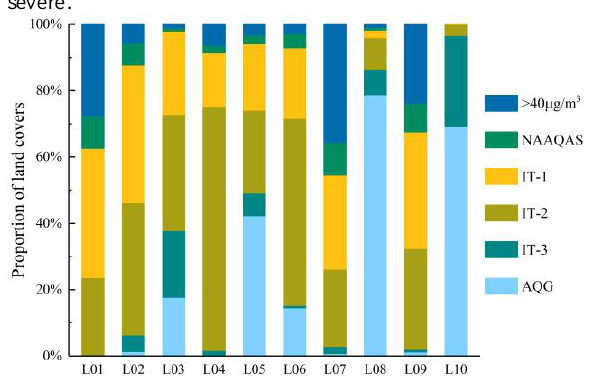
Figure 3. Proportion of PM 2.5 at each level in different LC types In order to further explore the characteristics of PM 2.5 in different LC types in India, average PM 2.5 from 1998 to 2015 in different LC types were counted respectively (Figure 3).